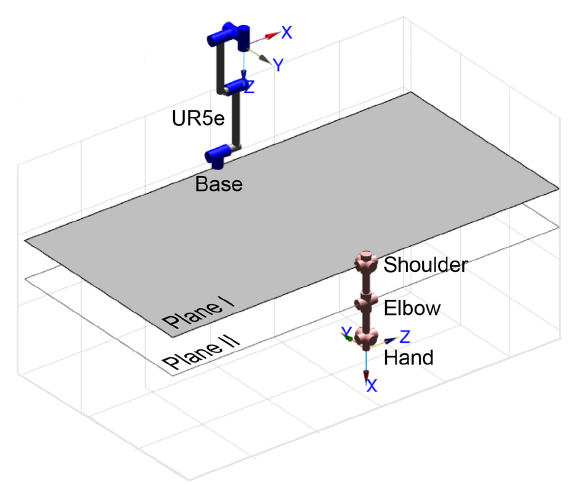
Figure 7. Domain of the robot’s base position for the optimization